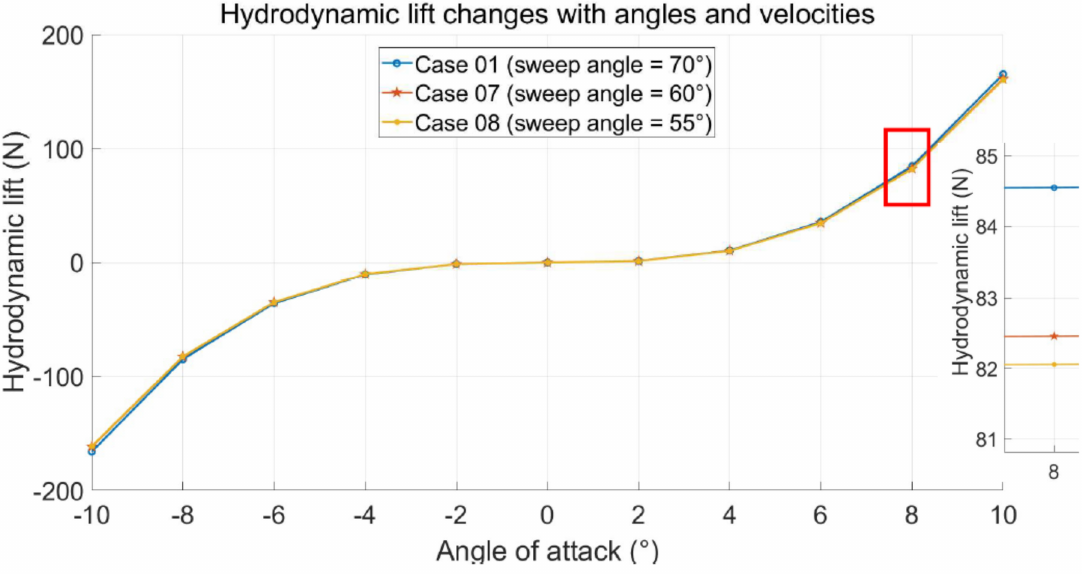
Figure 10. Changes in the hydrodynamic lift with angles and